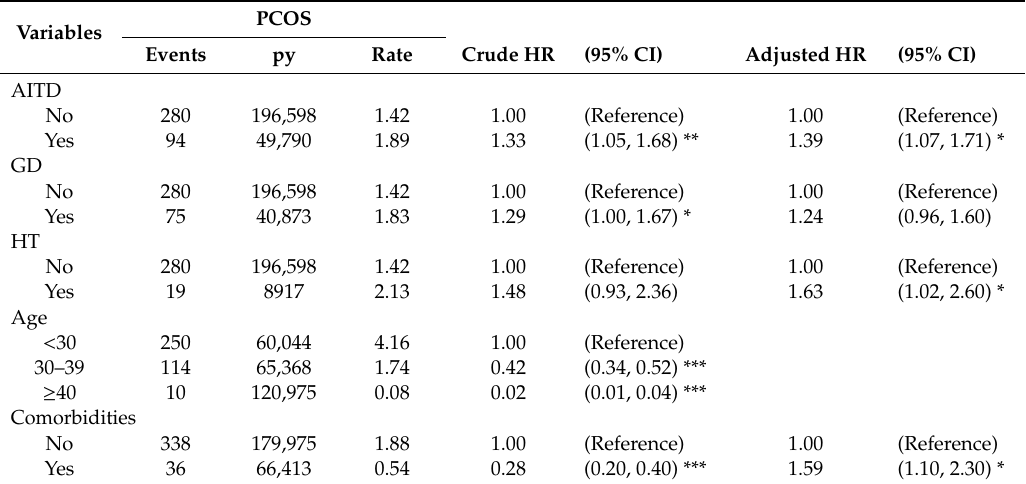
Figure 1. The cumulative incidence of polycystic ovary syndrome(PCOS) in the patients with and without autoimmune thyroid disease (AITD). Table 2. The incidence rate and the hazard ratios of polycystic ovary syndrome